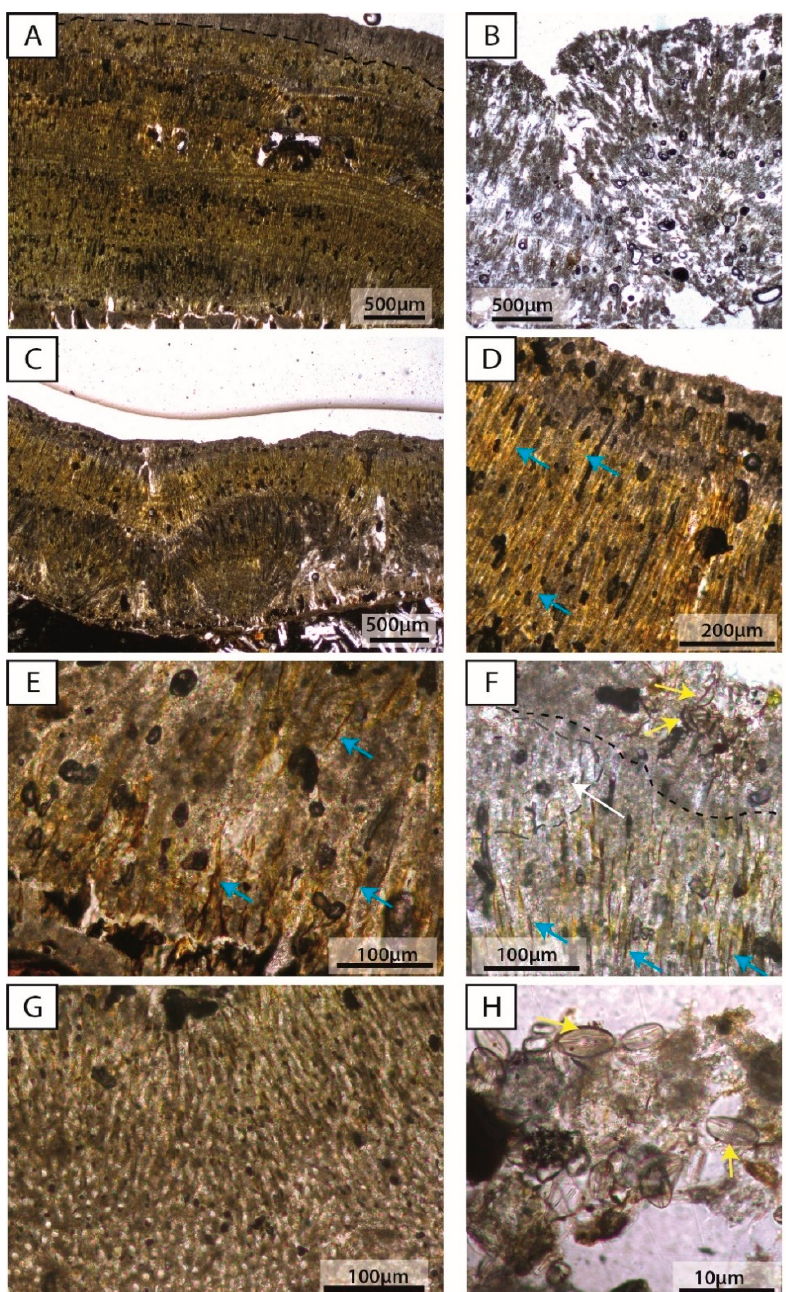
Figure 2. Photomicrographs under the transmitted light of the thin sections of the dried crust samples (Figure 1). ( A ) Dense crust with slightly visible plane parallel laminations. ( B ) Porous crust. ( C ) Dense crust and fan-shaped structure visible in the lower portion. ( D ) Enlargement of the upper part of the dense crust. Blue arrows show filaments. ( E ) Enlargement of the lower section of the dense crust with visible micrite. Blue arrows show filaments. ( F ) Enlargement of the porous crust. Diatoms are visible in the upper part (yellow arrows). White arrow shows the microsparite area. The micrite is homogenously distributed in the rest of the photograph; microorganisms (yellow arrows) and elongated filamentous structures (blue arrows) can be observed. ( G ) Enlargement of the lowest part of the fan-like structures of the dense crust. Homogenous, rounded pores are visible in the micrite observed in the lower part, while the upper part contains more elongated filaments. ( H ) Diatoms (yellow arrows) and other microorganism contained in the upper part of the porous crusts.